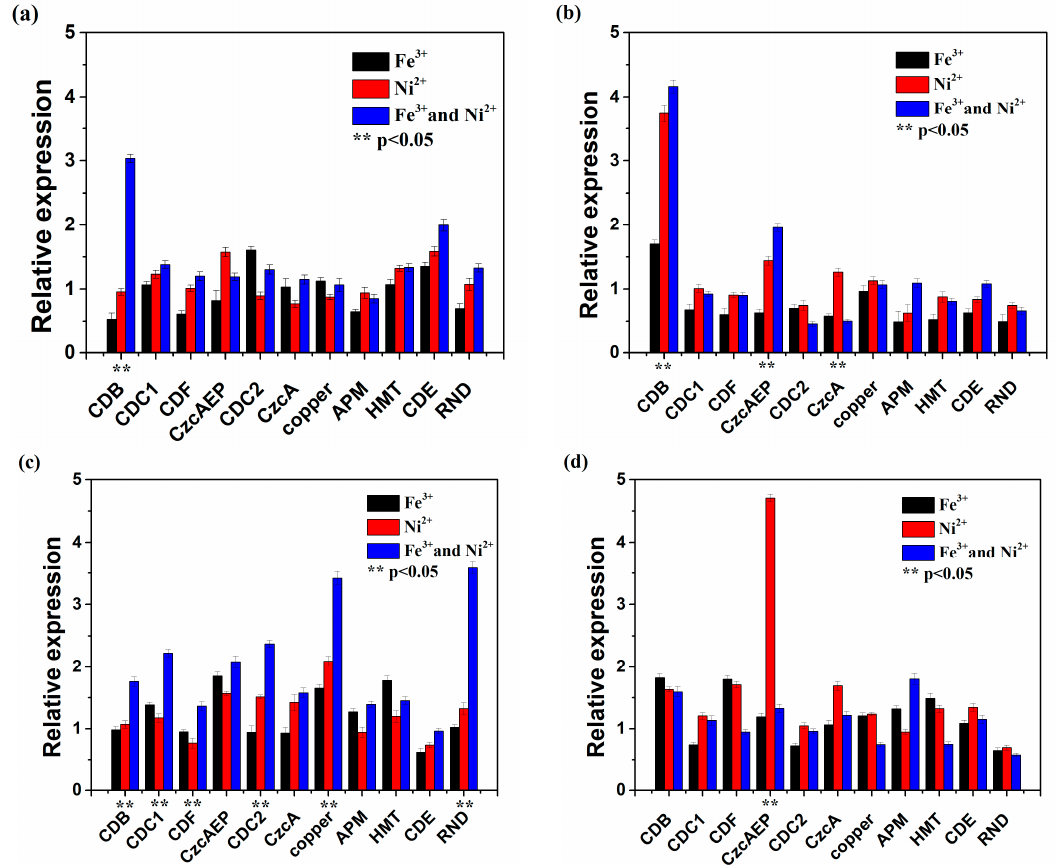
Figure 4. The expression of metal resistance-related genes in At. thiooxidans A01 in 10th min ( a ), 30th min ( b ), 60th min ( c ), 120th min ( d ) after single or joint Ni 2+ and Fe 3+ shock.